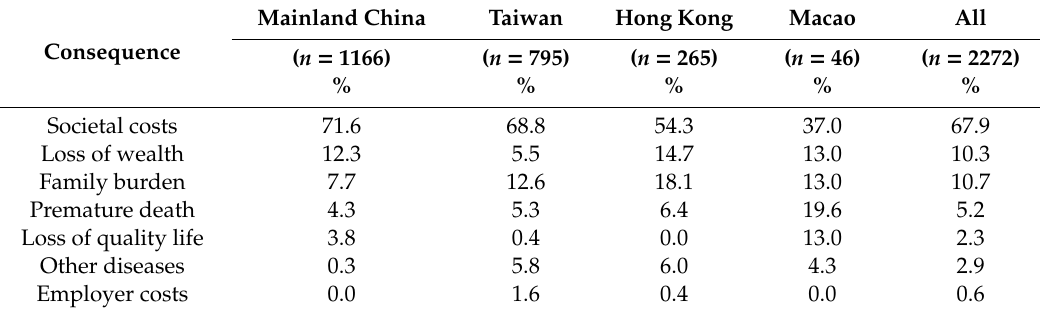
Table 3. Cost consequences of NCDs in newspaper coverage in mainland China, Taiwan, Hong Kong, and Macao between